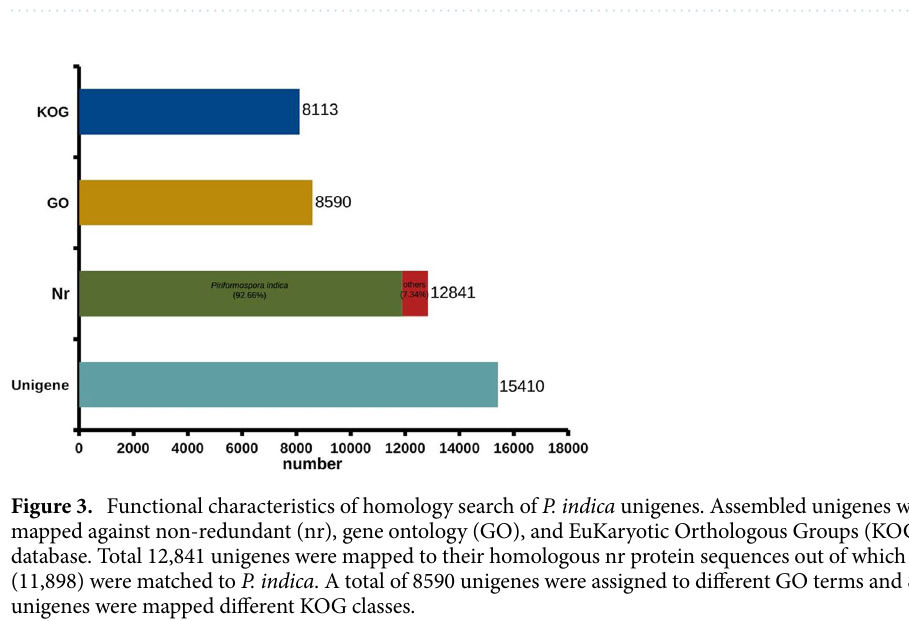
Figure 2. Length distribution of unigenes in the de novo assembled P. indica transcriptome.